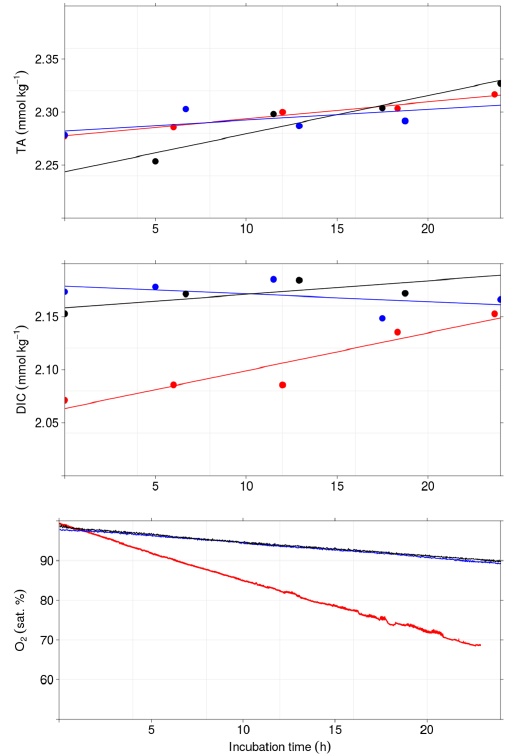
Figure 3. Representative concentrations of A T , DIC and O 2 satu- ration over time for all three regions of the North Sea. Red: Station 11 (SNS); blue: Station 71 (NNS); black: Station 65